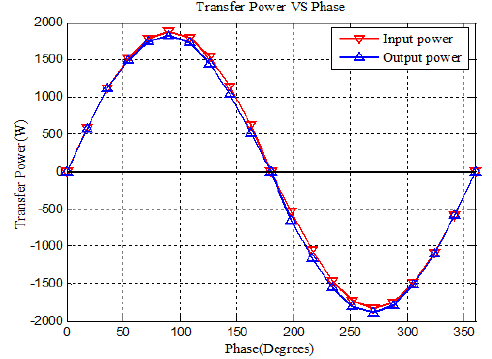
Figure 16. Input and output voltage vs. phase.